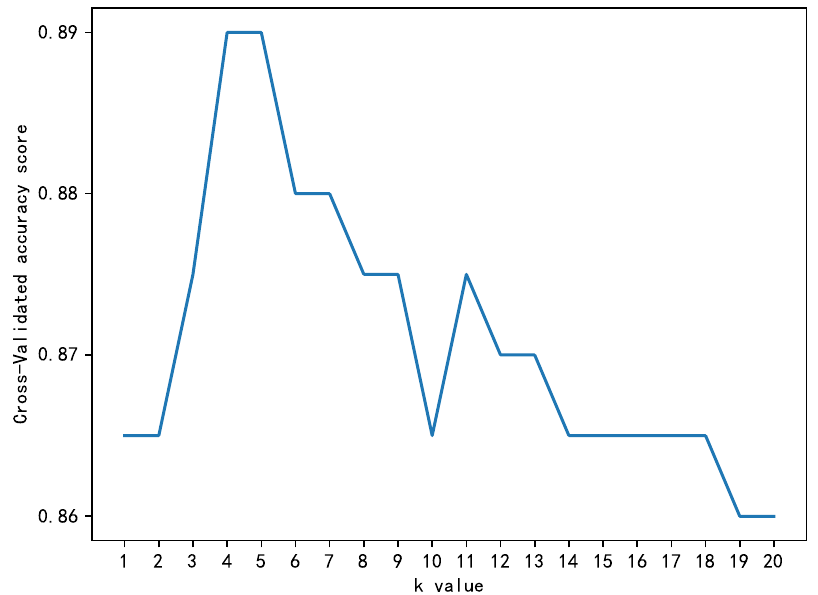
Figure 9. Cross-validated accuracy score scatter diagram.